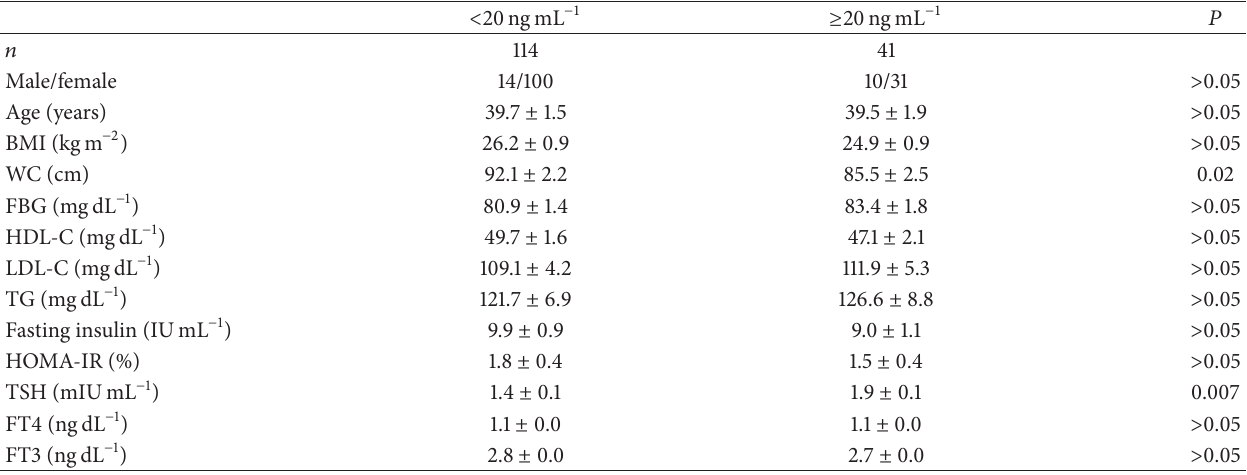
Table 2: Characteristics of participants according to the vitamin cut-off level of 20 ngmL − 1